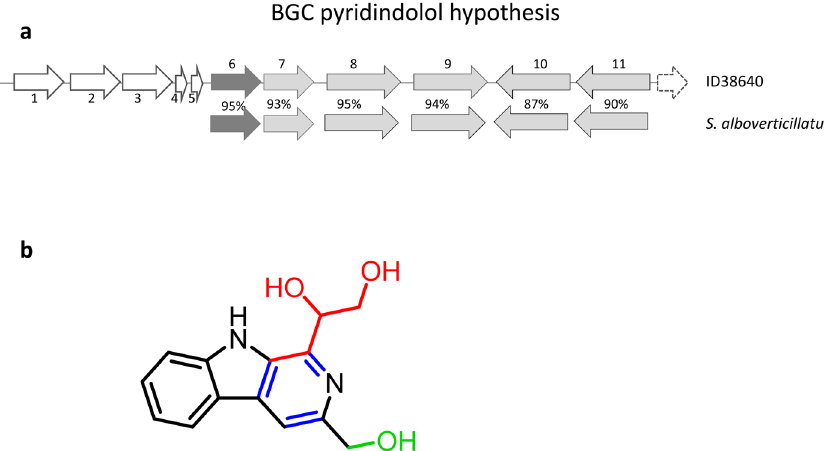
Figure 2. Putative pyridindolol BGC and hypothetical roles in metabolite formation. ( a ) Identified region containing the PSase homolog (dark grey) from the ID38640 genome (top) and syntenic region found in the pyridindolol producer S. alboverticillatus (bottom). The percent identities between orthologs are shown, while deduced functions are reported in Table 4. ( b ) Pyridindolol structure, highlighting the likely building blocks tryptophan (black) and glyceraldehyde (red), and the modifications necessary, aromatization (blue) and reduction (green), for the final